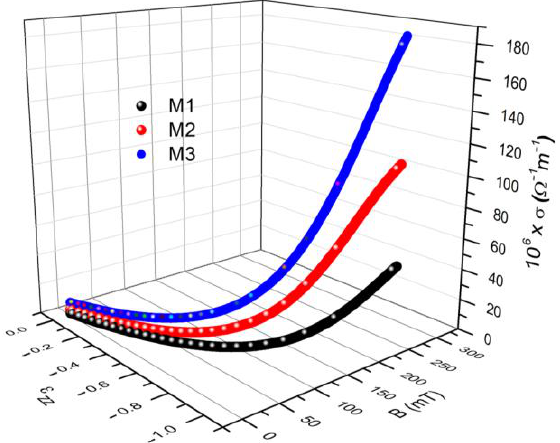
Figure 10. The electrical conductivity σ and the components ε zz of the deformations induced in the membranes M i ( i = 1,2,3 ) depending on the values of the magnetic flux density.